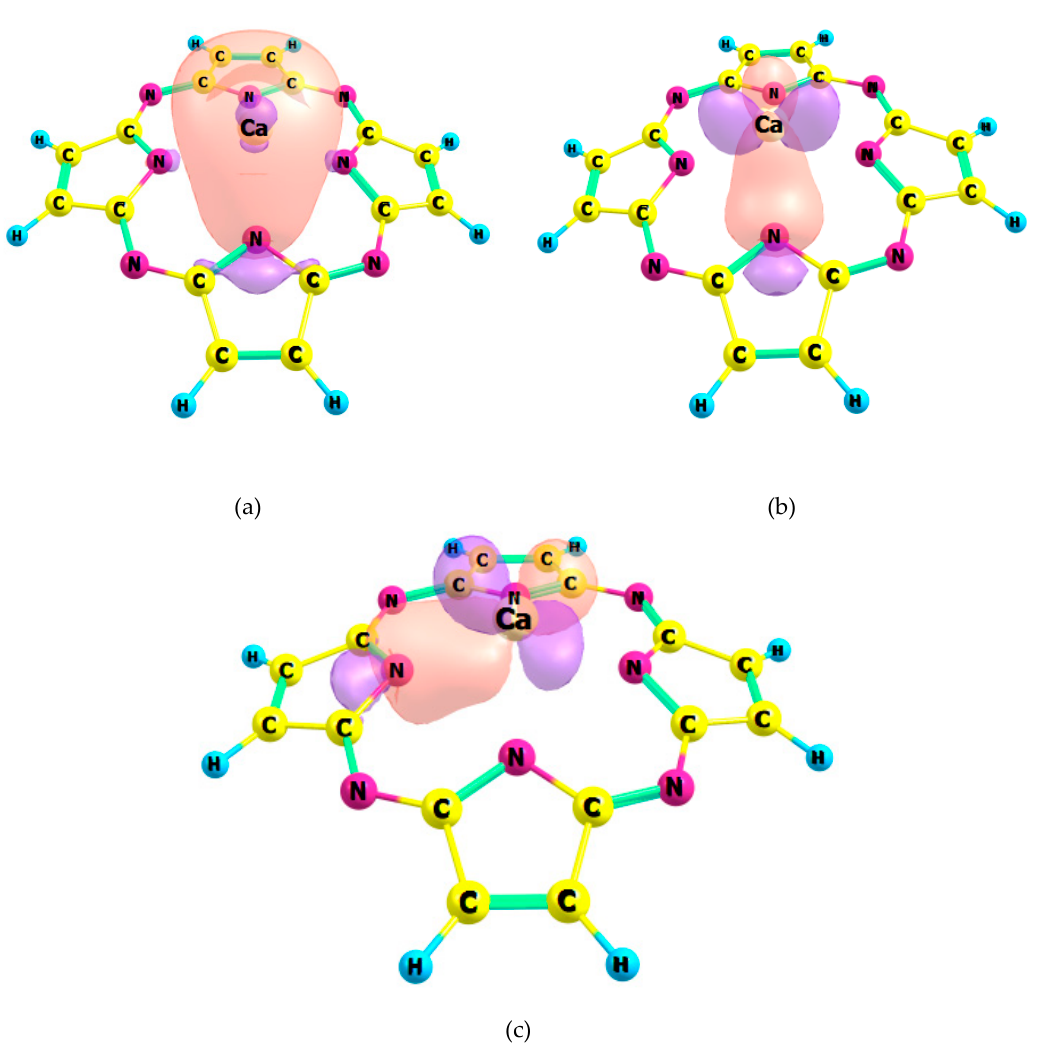
Figure 3. Schemes of the dominant donor-acceptor interactions between Ca and Pz ligand. The results of the: ( a ) orbital interaction of the type LP(N) → 4s(Ca) (E (2) = 11.0 kcal mol − 1 ); ( b ) orbital interaction of the type LP(N) → 3d x2 − y2 (Ca) (E (2) = 3.5 kcal mol − 1 ); ( c ) orbital interaction of the type LP(N) → 3d yz (Ca) (E (2) = 3.9 kcal mol − 1 ).